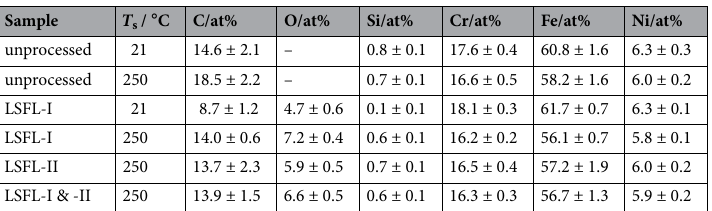
Table 1. Energy-dispersive X-ray analysis of stainless steel specimen at different sample temperatures T s and surface positions. The errors are standard